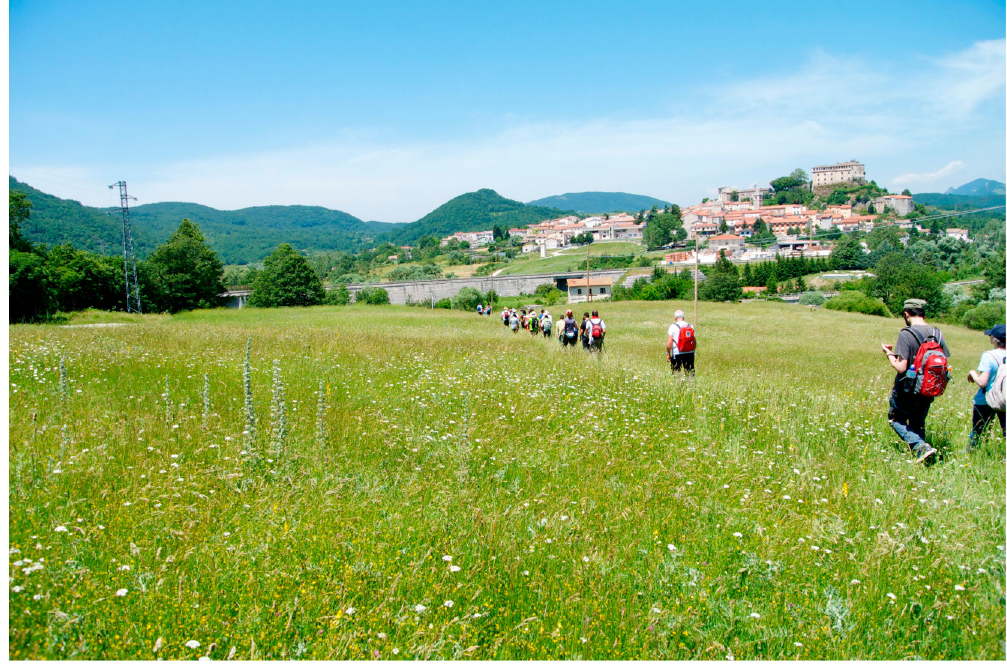
Figure 1. Trekkers along the Tratturo Castel di